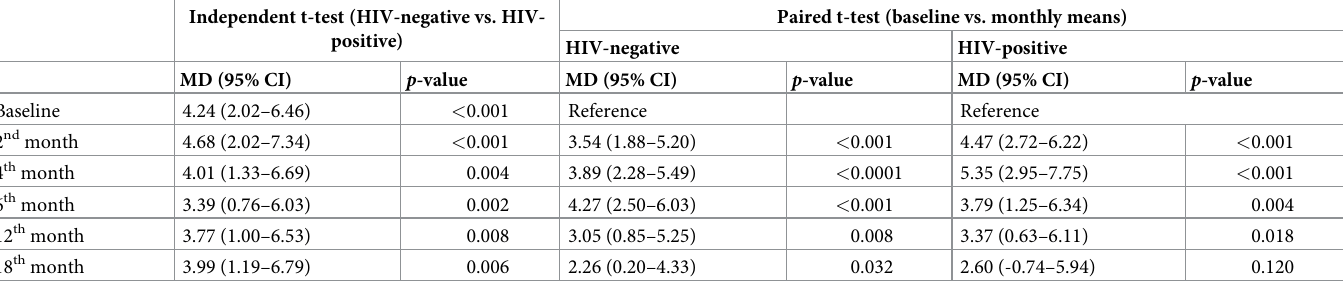
Table 3. Comparison of mean serum albumin differences according to HIV status and between baseline and follow-up months. Independent t-test (HIV-negative vs. HIV- positive)